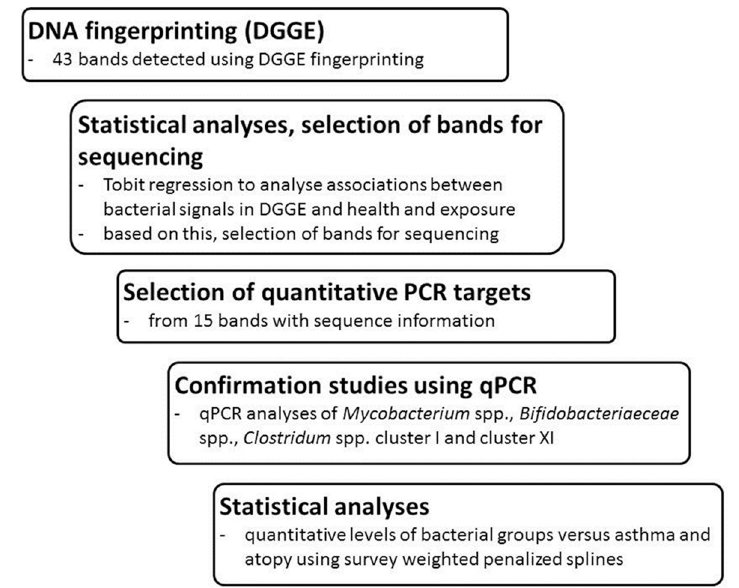
Fig 1. Flowchart of the study. Flowchart of molecular analyses (DGGE fingerprinting, quantitative PCR), statistical analyses, and the selection of bands for sequencing and qPCR